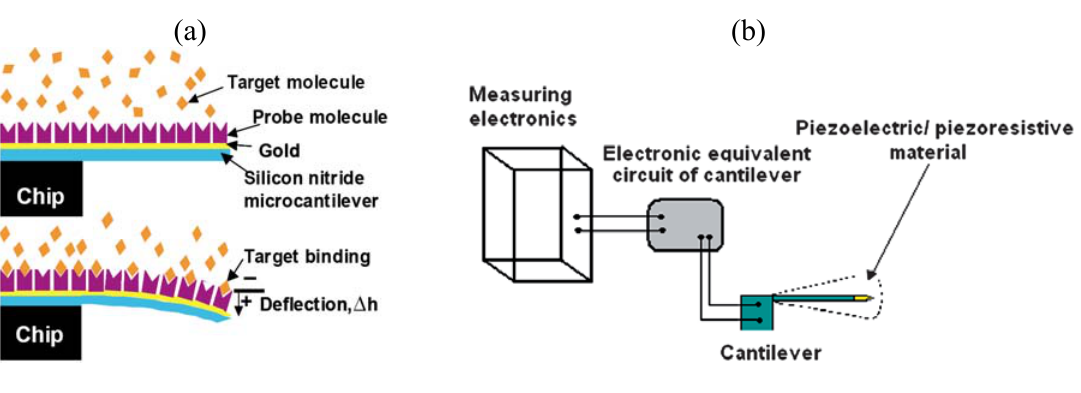
Figure 5. MEMS cantilever-based sensor. Target binding causes cantilever deflection, reprinted from [65] with permission from Macmillan Publishers Ltd, and piezoresistor detection, reprinted from [63] with permission from The Royal Society of